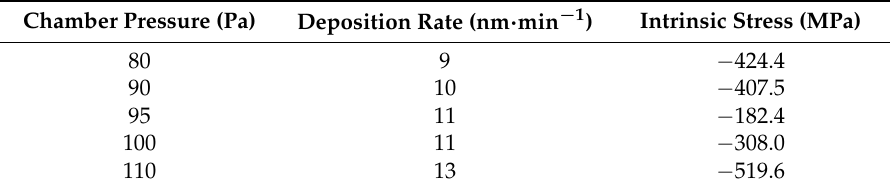
Table 4. Influence of chamber pressure on the intrinsic stress level and deposition rate.